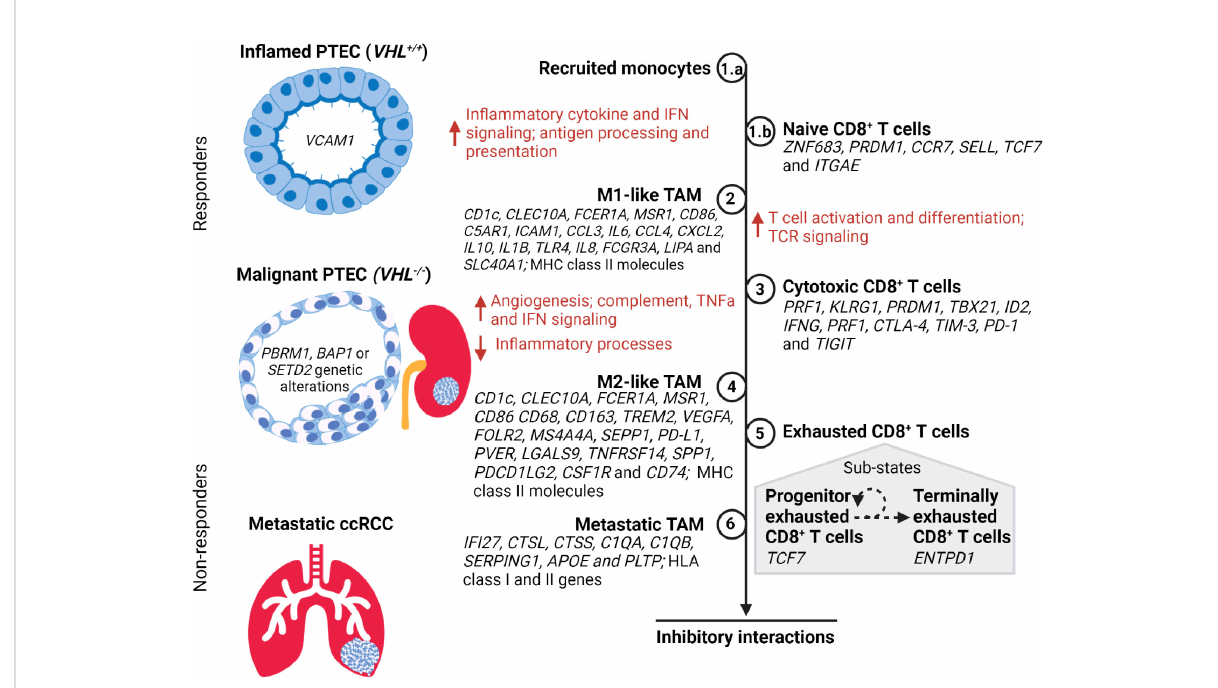
FIGURE 2 A timeline of tumor-associated macrophage (TAM) and CD8 + T cell states during the transition of PTEC in the development of ccRCC. During hypoxic injury, the in fl amed PTEC increase the expression of in fl ammatory cytokine and interferon gamma (IFN) signaling to recruit monocytes (Step 1.a) from the peripheral circulation. These recruited monocytes transition to M1-like TAM states (Step 2) and commence antigen processing and presentation, thus activating the naïve CD8 + T cells (Step 1.b) within the kidney to transition to the cytotoxic CD8 + T cell state (Step 3). During the malignant PTEC state, the M1-like TAMs increase angiogenesis, complement, tumor necrosis factor alpha (TNF a ), and IFN signaling. However, as the ccRCC lesion progresses, the M1-like TAMs transition to the M2-like TAM state (Step 4). The cytotoxic CD8 + T cells transition to an exhausted CD8 + T cell state (Step 5) composed of a heterogeneous mix of progenitor and terminally exhausted states (51, 52). The subpopulation of exhausted CD8 + T cells that exhibit progenitor transcriptome may respond to immune checkpoint therapy until they attain a terminally exhausted CD8 + T cell state. In metastatic ccRCC, the M2-like TAM (Step 6) attain metastatic TAM transcriptome pro fi le expressing both the HLA class I and II genes. However, in advancing ccRCC lesions, the M2-like TAMs and exhausted CD8 + T cells co-occur and form inhibitory interactions that limit response to immune checkpoint